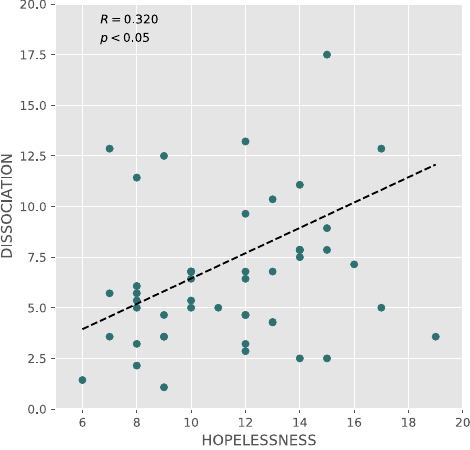
Figure 2. Correlations between hopelessness and dissociation.